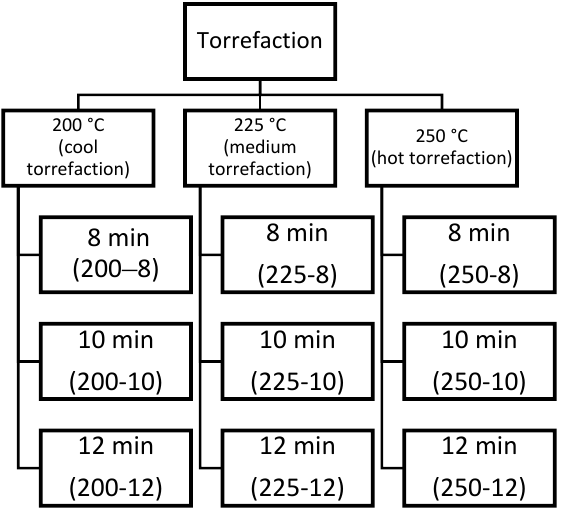
Figure 1. Temperature and time for the torrefaction of the biomass of five fast-growth plantation species of Costa Rica. Note: the numbers in parentheses indicate the abbreviation of this torrefaction condition.